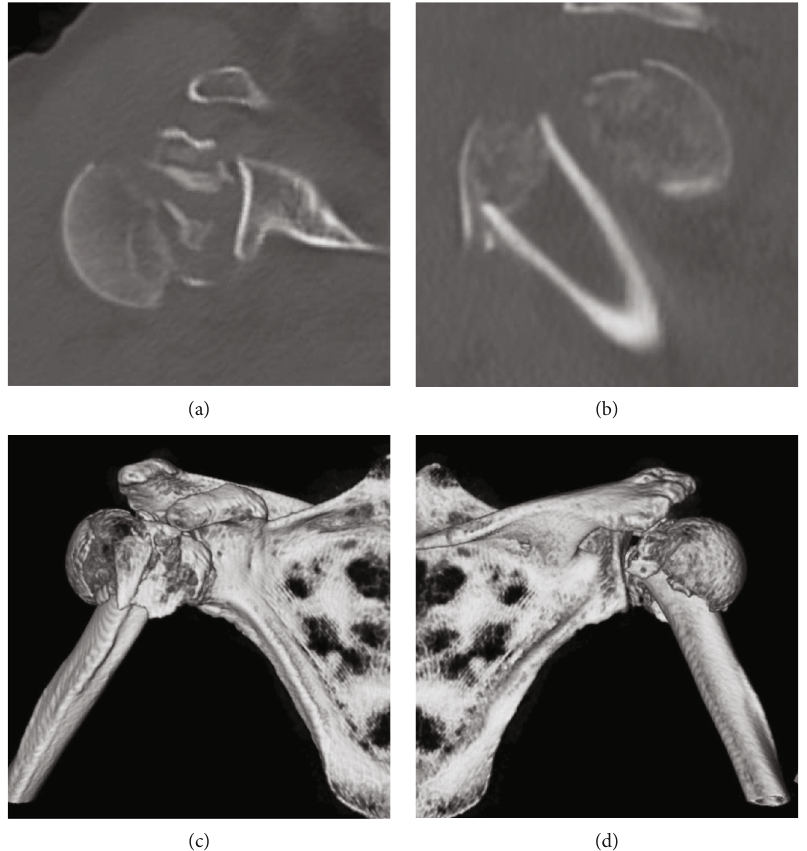
Figure 2: Computed tomography images of the right shoulder showing the four-part fracture with dislocation of the proximal humerus: (a) axial image, (b) sagittal image, (c) frontal view in a three-dimensional (3D) image, and (d) posterior view in a 3D